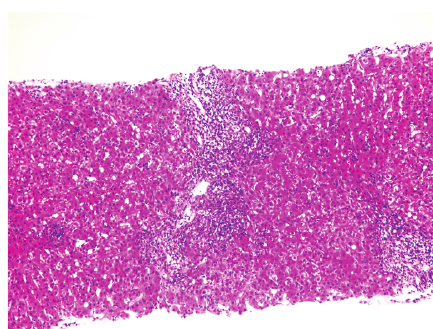
Figure 1: Liver biopsy. Marked portal lymphoplasmacytic inflam- mation with periportal interface hepatitis and scattered lobular necroinflammatory changes may be seen. (hematoxylin and eosin; ×